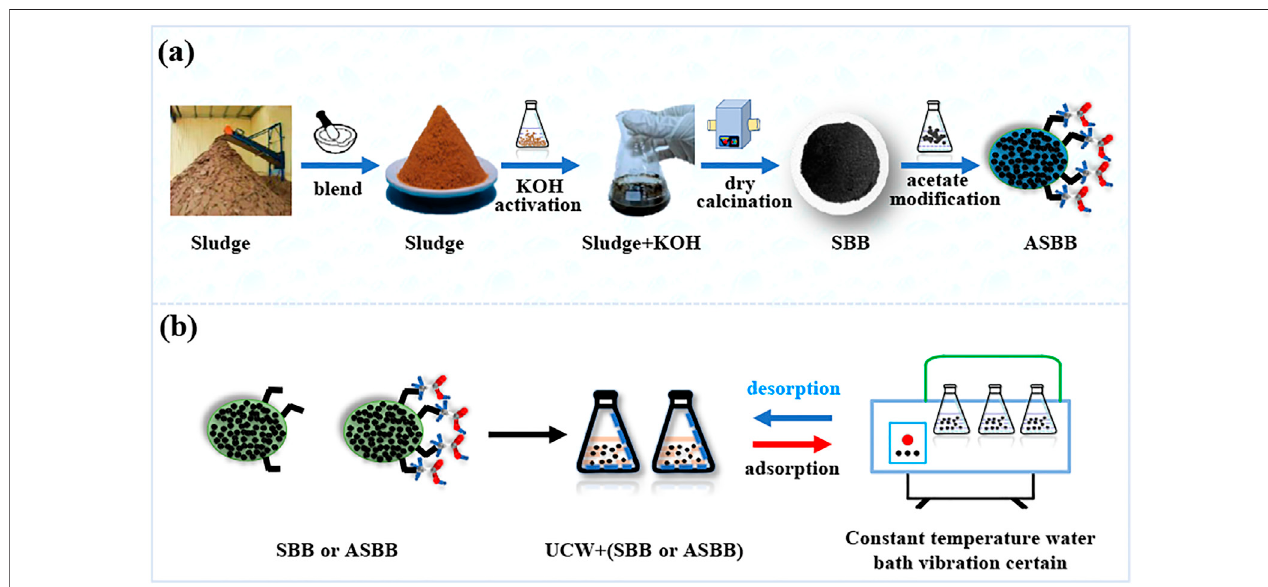
FIGURE 1 | Preparation of sludge-based biochar (SBB) and acid-modi fi ed sludge-based biochar (ASBB) and uranium recovery from uranium-containing wastewater (UCW). (A) Preparation of SBB and ASBB. (B) Uranium recovery from UCW by SBB or ASBB.